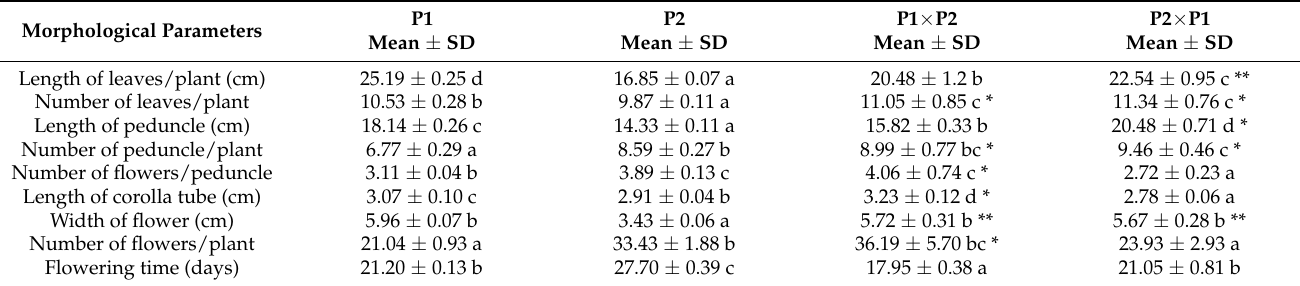
Table 2. Mean comparisons for morphological characters of parents and F 1 plants from two recipro- cal